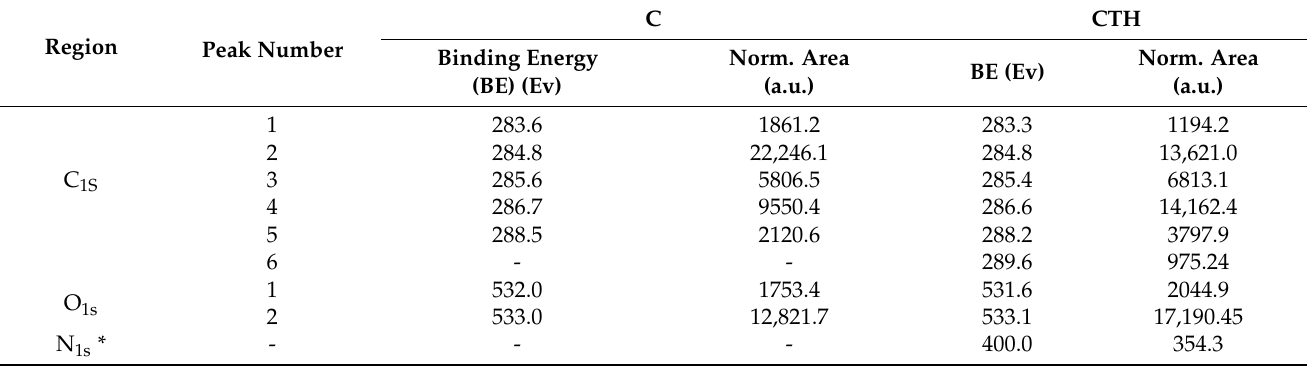
Table 4. Fitting parameters of the C 1s , O 1s , and N 1s detailed regions for both the CTH and C